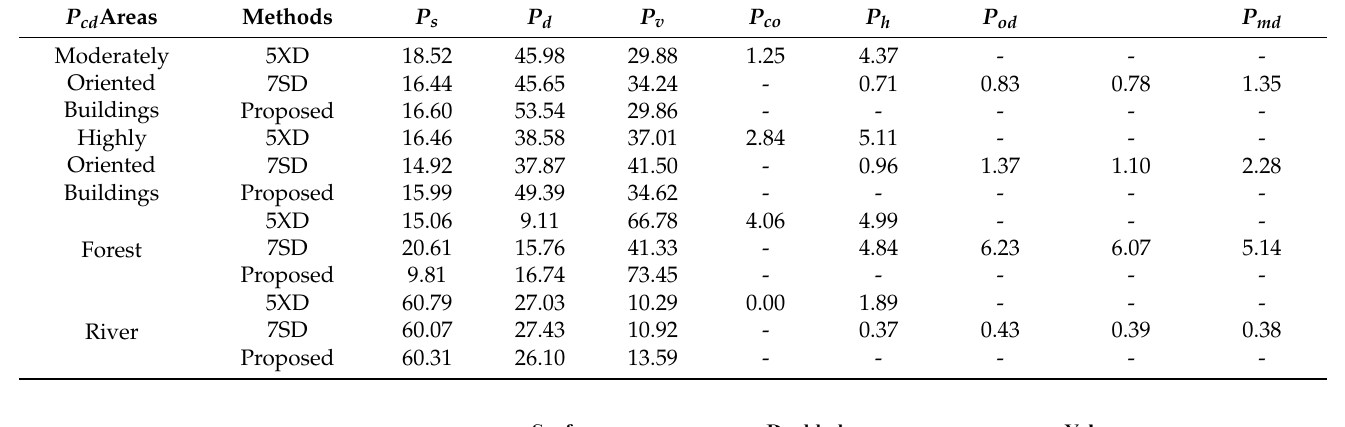
Table 7. The mean ratios of the different scattering powers for the different decomposition meth- ods (%).